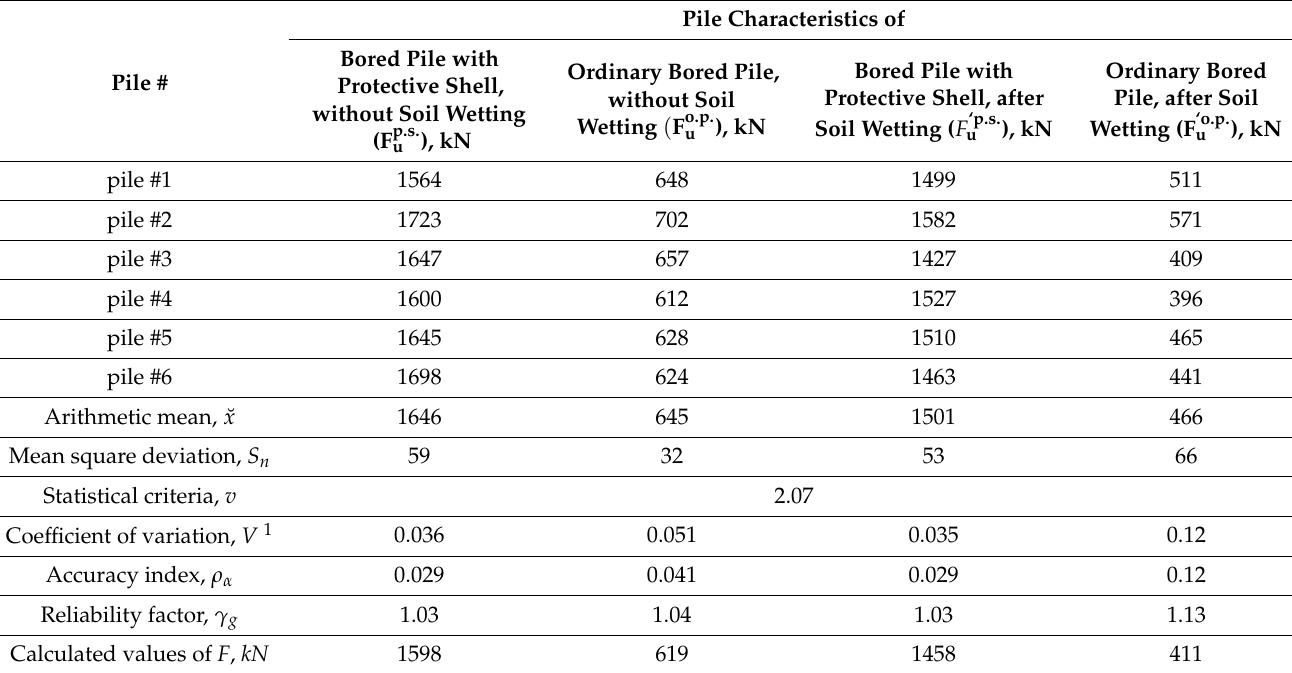
Table 2. Bearing capacity of piles according to the results of static pile load tests (SLT) and the results of statistical processing.